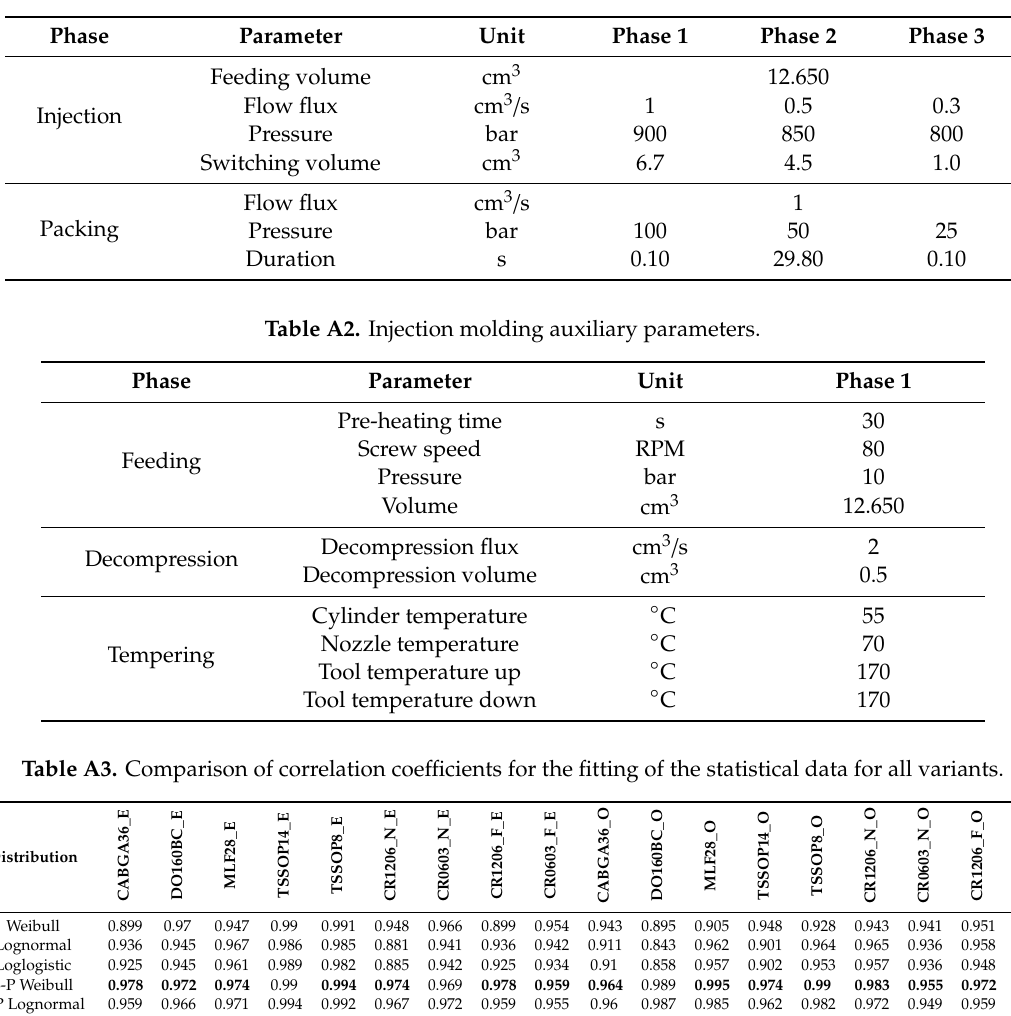
Table A1. Injection molding process parameters.